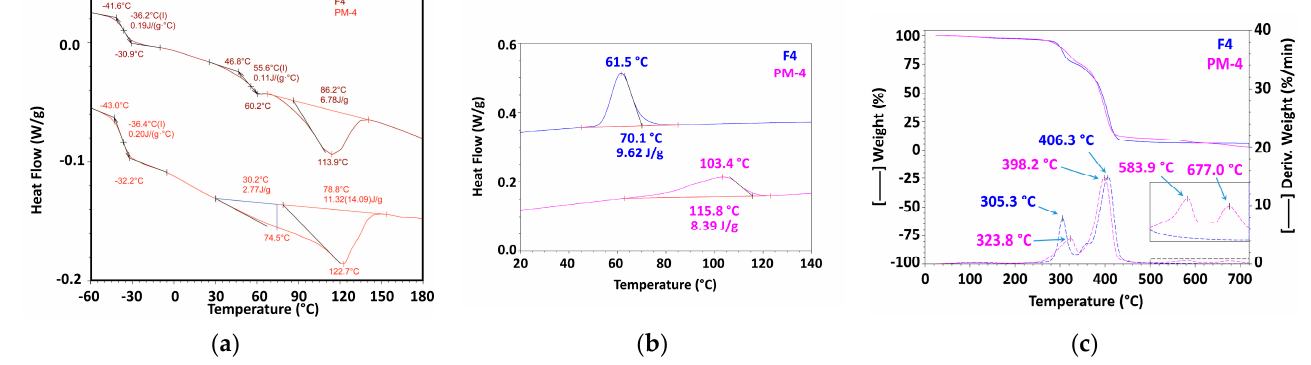
Figure 7. The thermal behavior of mechanically recycled (PM4) and primary compounds (F4) (( a ) melting from second heating run; ( b ) crystallization; ( c ) TGA). The F4 compound crystallized at 61.5 ◦ C in a process that started at 70.1 ◦ C and released 9.62 J/g (Figure 7c, Table 4), while the PM4 compound crystallized at 103.4 ◦ C, i.e., at a 42 ◦ C higher temperature, starting at 115.8 ◦ C and releasing8.39 J/g (Figure 7c, Table 7). The F4 compound lost 2.31% of its weight up to 175 ◦ C with a maximum at 118.4 ◦ C. Between 175 ◦ C and 340 ◦ C it lost 22.9% with a maximum at 305.3 ◦ C and 67.43% between 340 ◦ C and 465 ◦ C with a maximum at 406.3 ◦ C. Between 465 ◦ C and 530 ◦ C, this compound lost 0.67% more, and between 530 ◦ C and 720 ◦ C it lost0.67% of its weight. The residue at 720 ◦ C was5.58% in nitrogen and 0.37% in air. By comparison, the mechanically recycled compound lost 1.89% up to 175 ◦ C with a maximum at 118.4 ◦ C, 22.9%